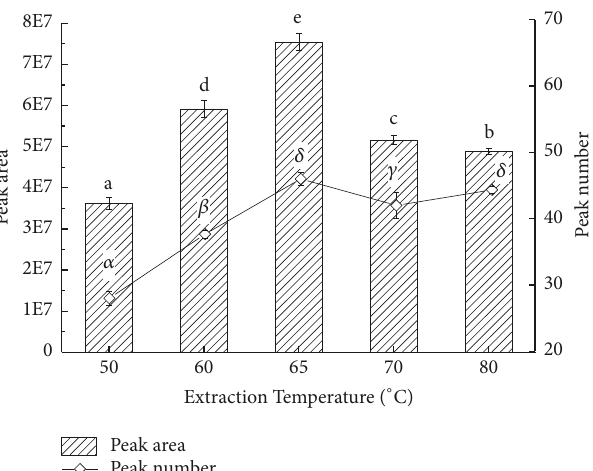
Figure 6: Effects of extraction temperature on extracting volatiles of pepper chicken soup. English letters “a”, “b”, “c”, “d”, “e” indicate Duncan’s multiple range test among peak areas of the five extraction temperatures. Greek letters “ 𝛼 ”, “ 𝛽 ”, “ 𝛾 ”, “ 𝛿 ” indicate Duncan’s multiple range test among peak numbers of the five extraction temperatures. Data in the same group marked with different letters mean significant difference ( p < 0.05) and the same letters denote not significant difference ( p <